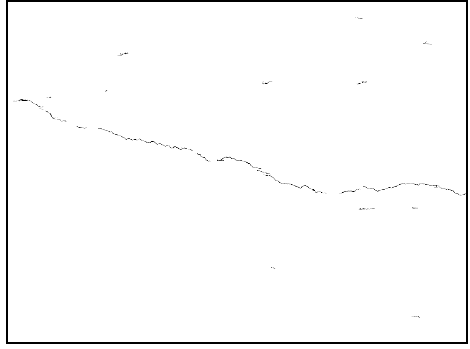
Figure 13. The result of crack detection